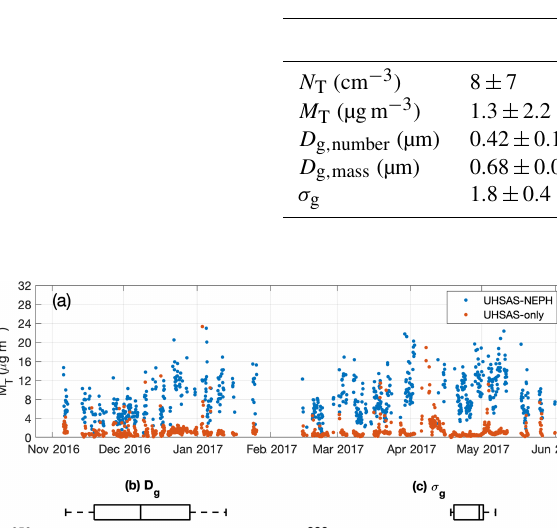
Table 5. UHSAS-only and UHSAS-NEPH number concentrations, mass concentrations, and size distribution fitting parameters. Values are the mean ± 1 standard deviation. Bracketed values are the minimum and maximum.